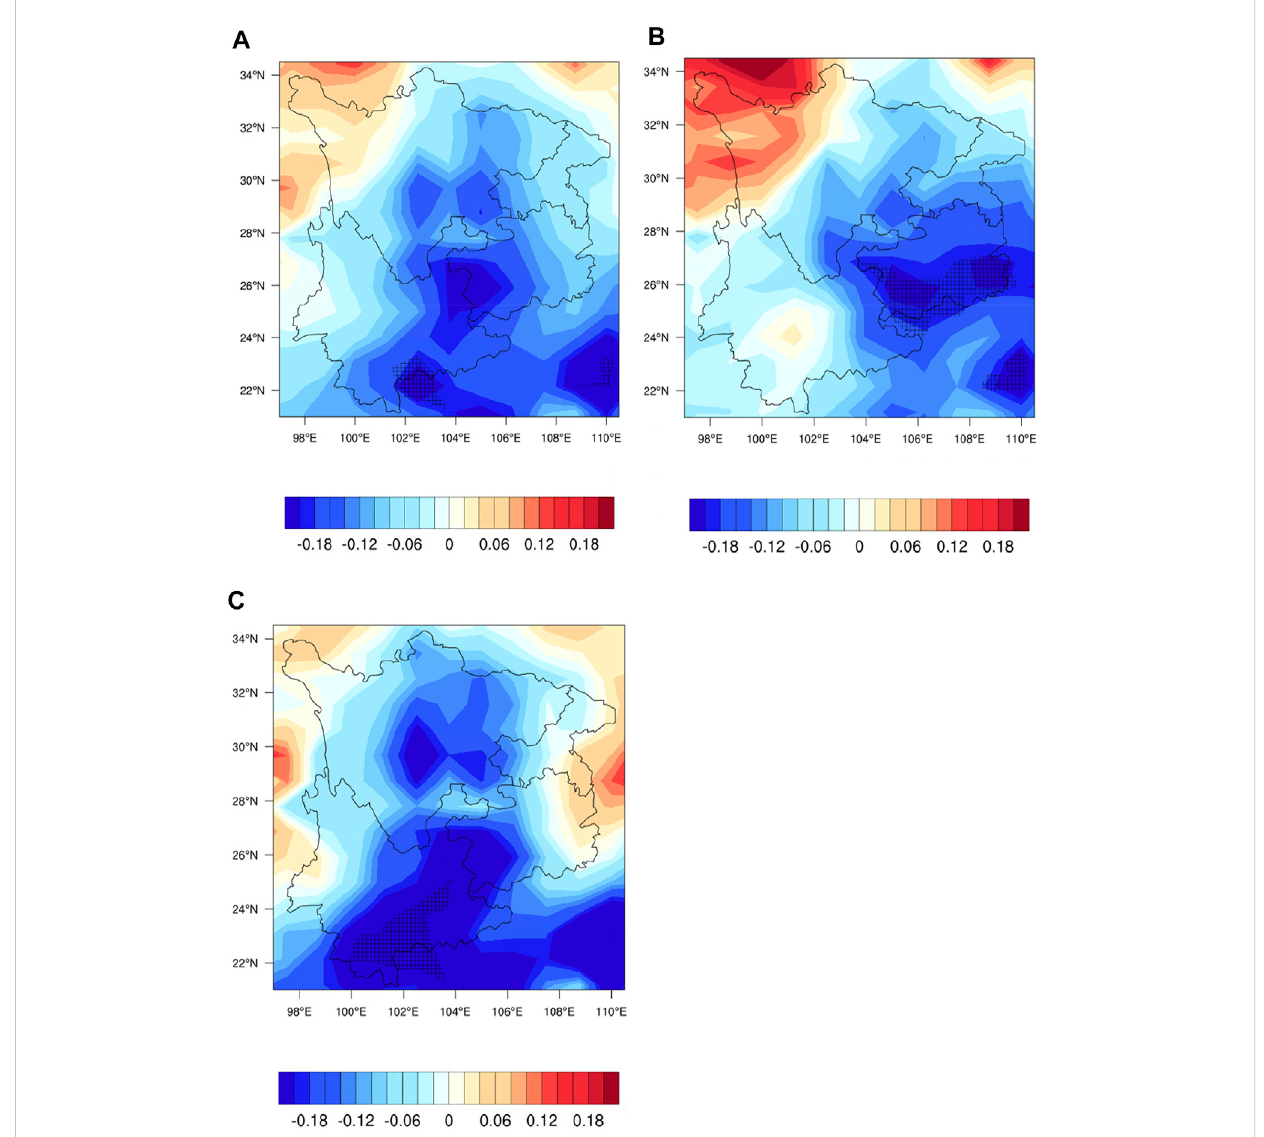
FIGURE 6 EffectsofAHRonsouthwestChinaintheborealsummer(JJA)from1992to2013: (A) 2-mairtemperature(T 2m ,unit: ° C); (B) minimum2-mairtemperature